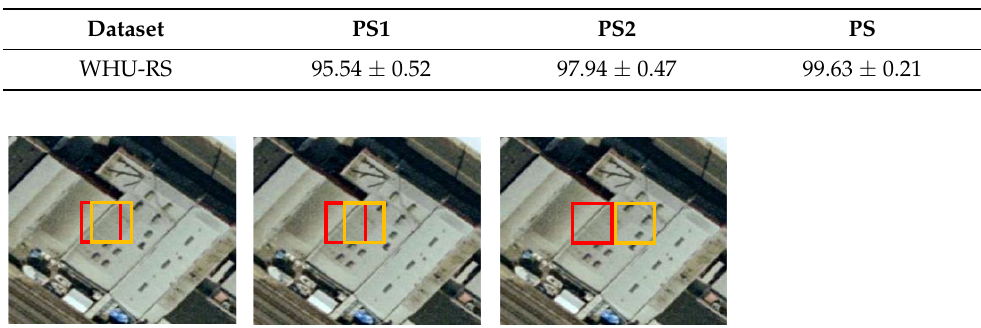
Table 4. Comparison of classification accuracy (%) based on different pixel strides (PS) with WHU-RS dataset. The PS1 and PS2 are corresponding to pixel stride 1 and 2. The PS represents the pixel stride equal to the patch size (4).